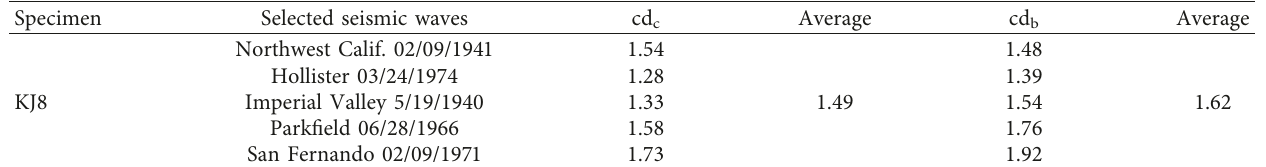
Table 26: Maximum curvature ductility coefficients of beams and columns in model